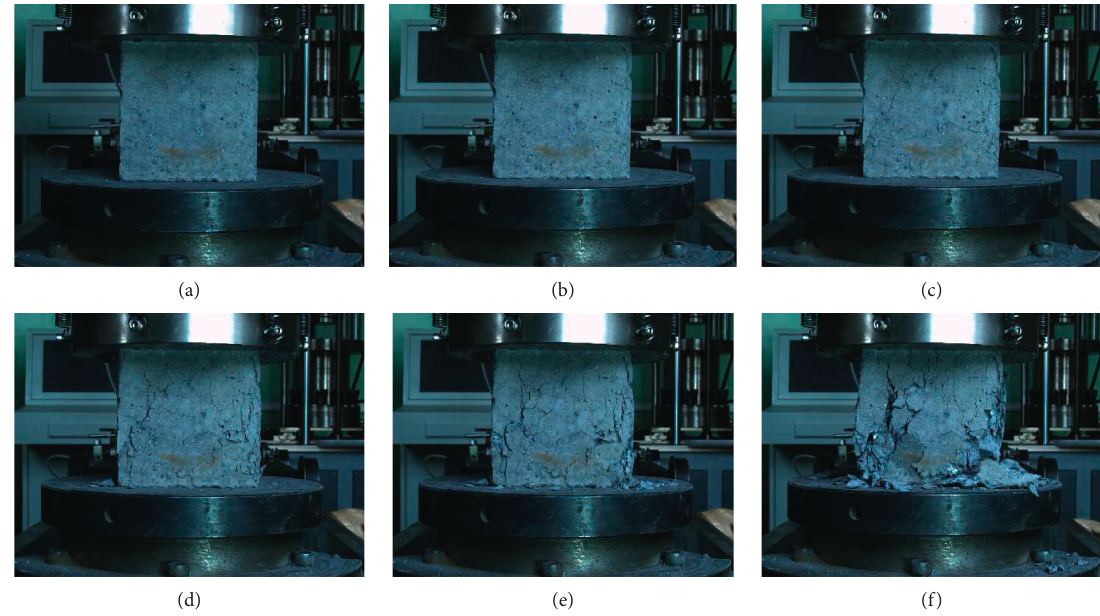
Figure 8: Characteristics of the external failure with 30% waste concrete substitution under uniaxial loading. (a–f) correspond to 0- σ σ b - σ c , σ b - σ c , σ c - σ d , and σ c - σ d of the stress stage in Figure 6.